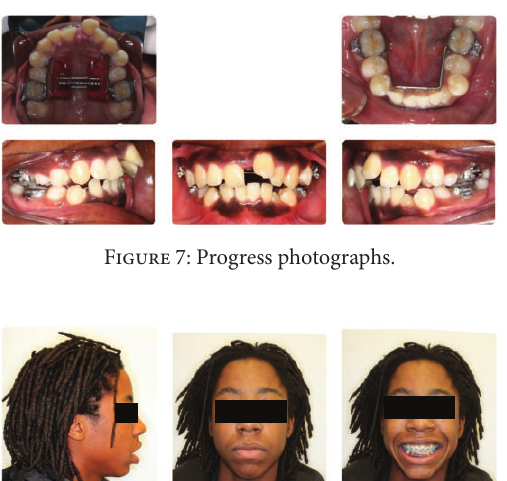
Figure 4: Initial panoramic radiograph.